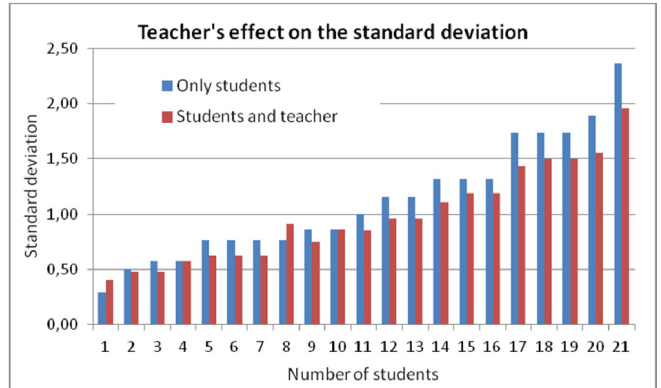
Figure 2. Standard deviaton of the grades given by students and the efect when the instructor’s grade is added (Only deviatons >0 are shown)